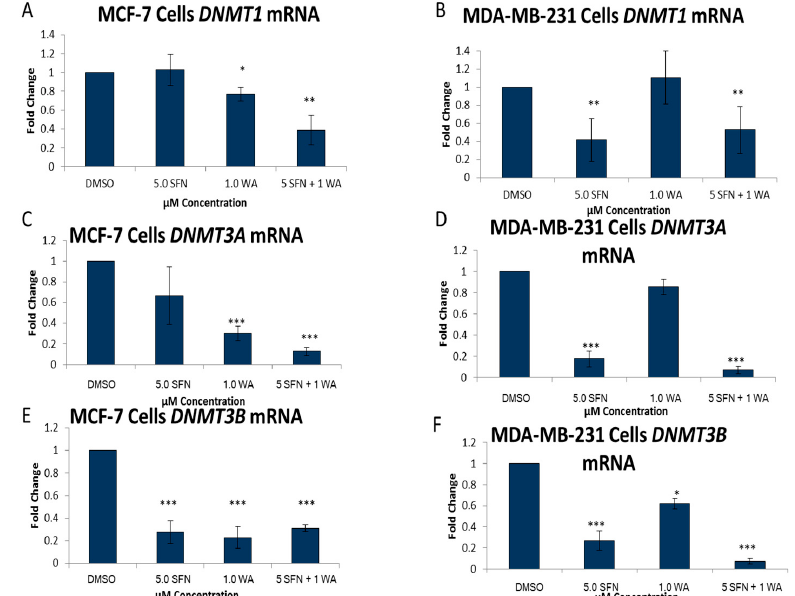
Figure 4. Combinatorial WA and SFN induce changes in the mRNA expression of DNMTs. ( A )